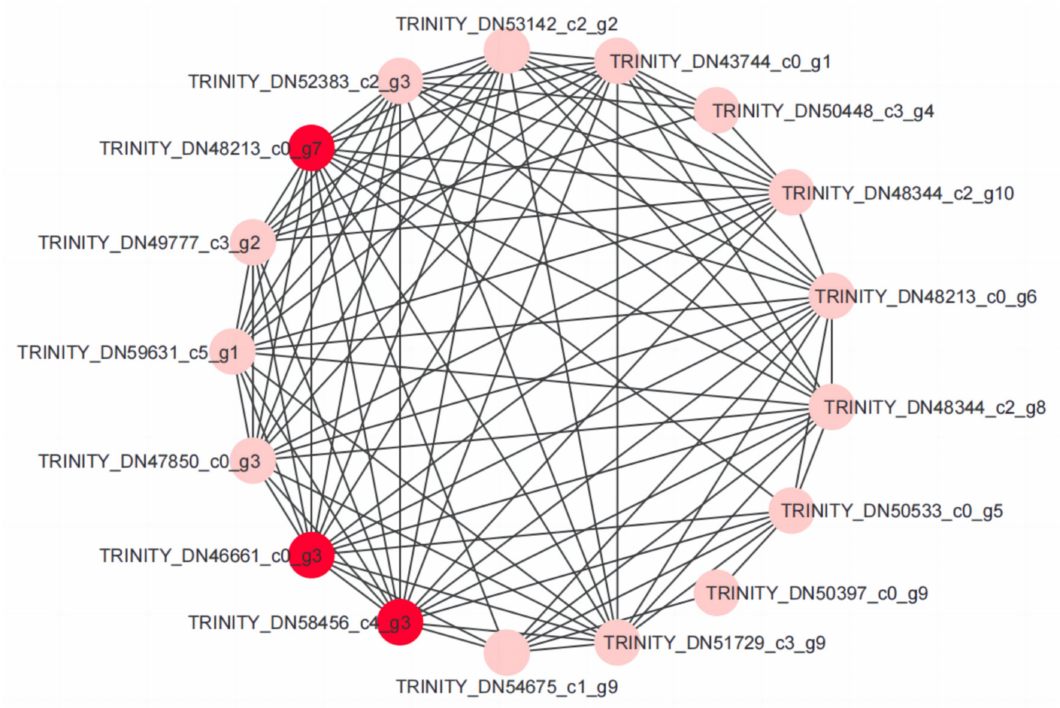
Figure 9. Construction of protein–protein interaction network model of drought-tolerant candidate genes in I. domestica by Cytoscape software. The red circles are hub